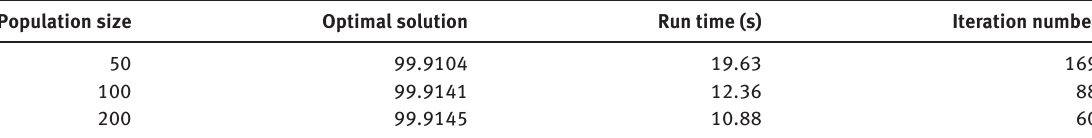
Table 3. Comparison of Running Results of Different Population Sizes. Population size